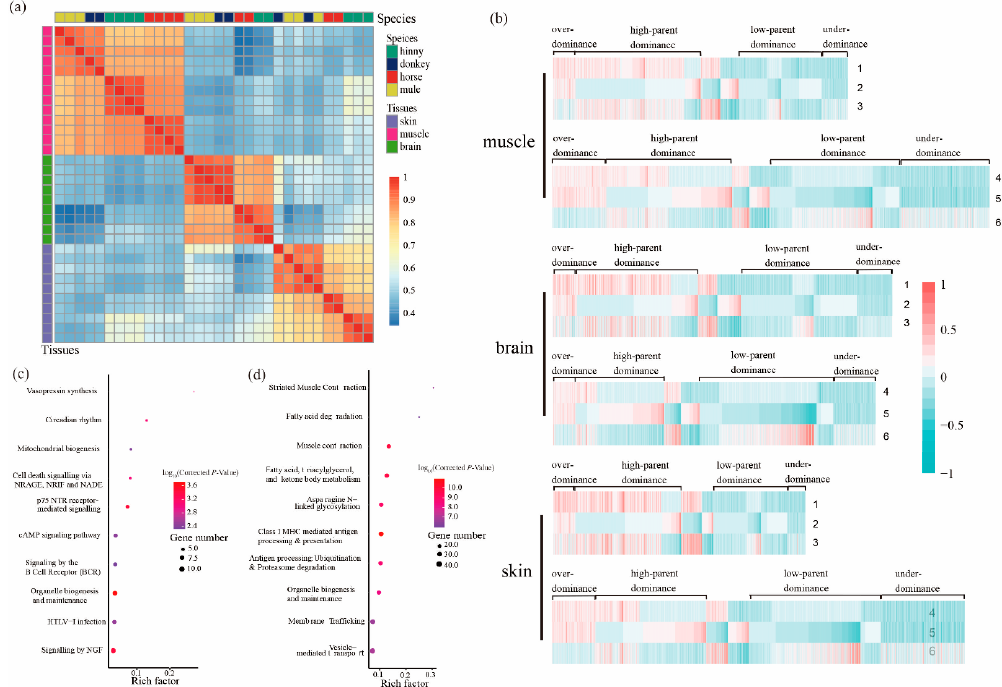
Figure 2. Genes with DAS events in the tissues of muscle, brain, and skin from mule, hinny, and their